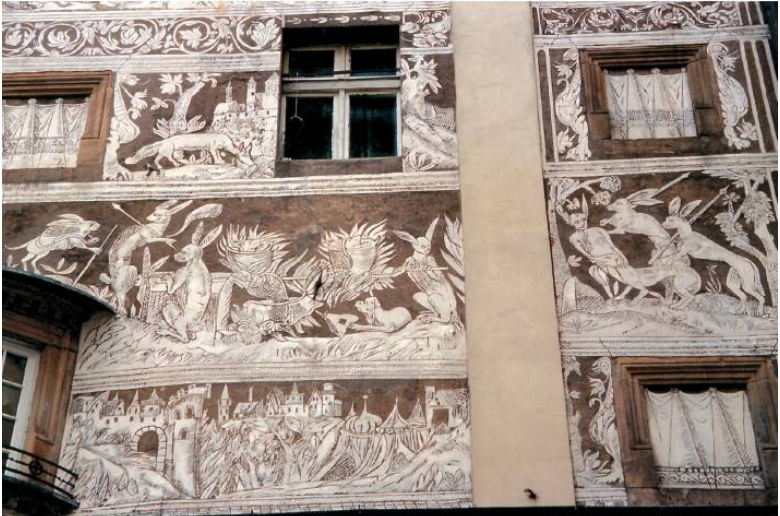
Figure 28. Fragment of the sgraffito decoration of the Legnica house “Under the Quail’s Basket” (Pod Przepiórczym Koszem) with the scene “the world upside down” and an illustration to one of Aesop’s fairy tales. Author’s photo, 2003.